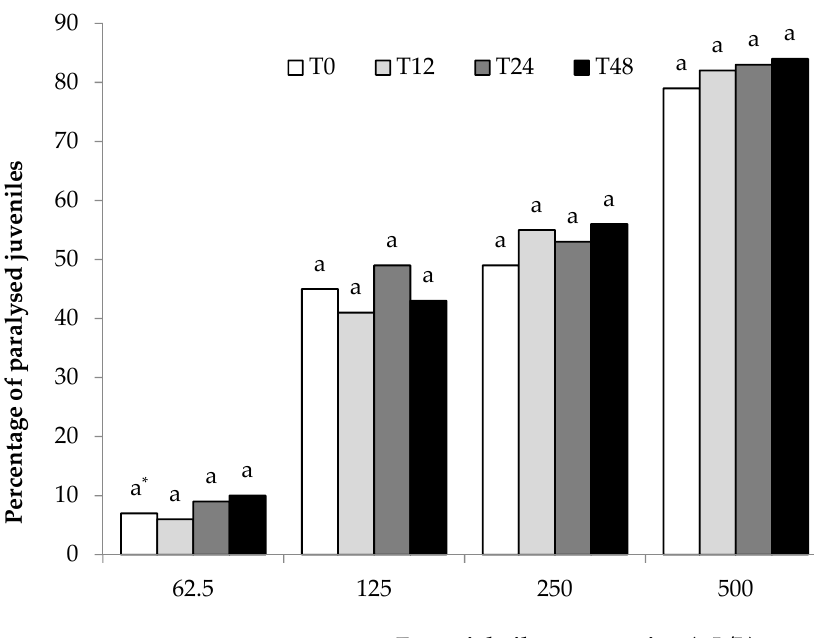
Figure 1. Effect of Cuminum cyminum seed essential oil on the motility of M. incognita J2s after immersion in test solutions at concentrations of 62.5, 125, 250, and 500 µ L/L for 12 h (T0), transferred in water, and counted after 12 (T12), 24 (T24), and 48 (T48) h. * Values for each concentration followed by the same letter are not significantly different according to Tukey’s HSD test at p < 0.05.